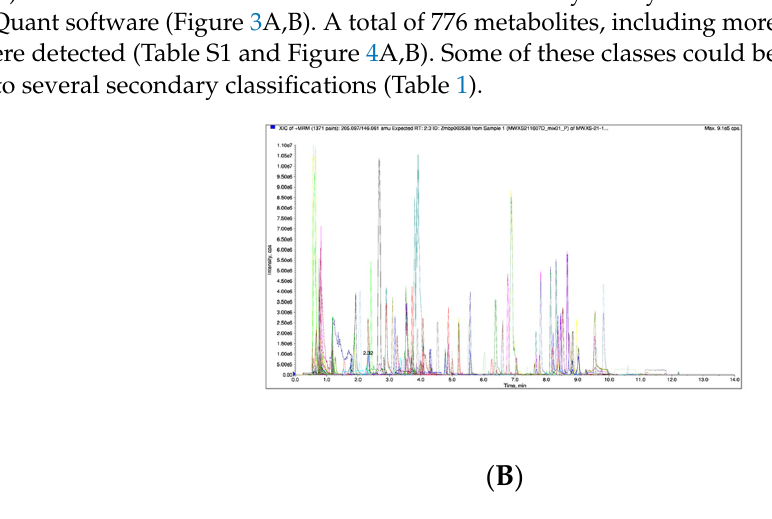
Figure 2. The CV distribution of each group.